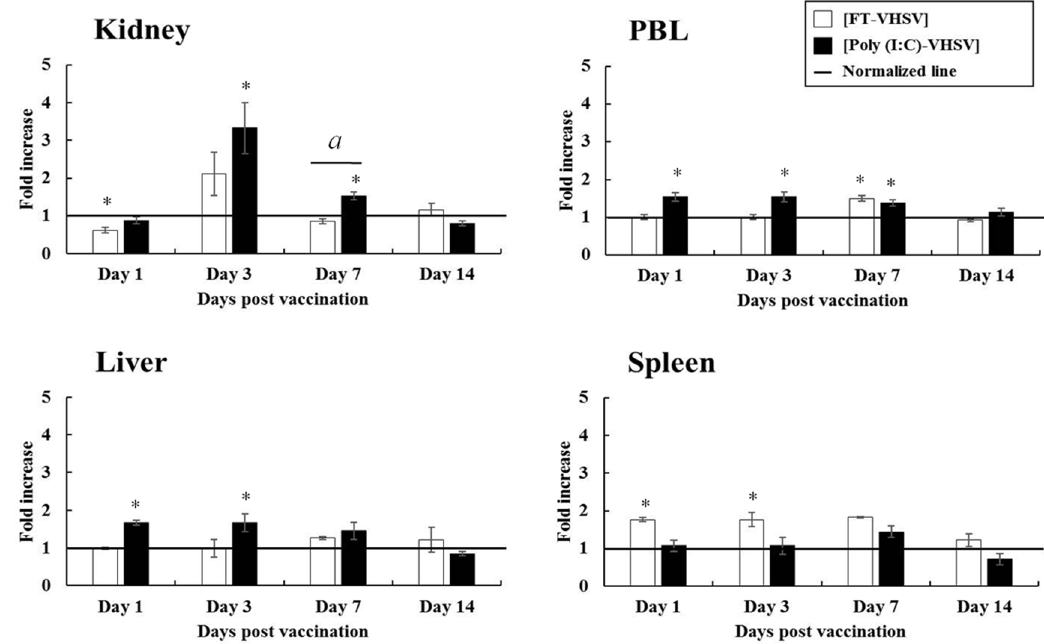
Figure 7. Fold increase in CD4-1 + T cell populations in olive flounder after poly (I:C) potentiated and formalin-treated VHSV vaccination determined by flow cytometry. Leukocytes were isolated at 1, 3, 7, and 14 dpv from the kidney, liver, spleen, and PBL for three fish from both the Poly (I:C)-VHSV ( n = 30) and FT-VHSV ( n = 30) groups. The CD4-1 + T cell response was observed and presented as a fold increase compared to the T cell population in the negative control group (adjusted to 1 and shown by a solid line). Error bars indicate the standard deviation of the mean. Asterisks (*) represent a significant difference between each experimental group and the negative control group by one-way ANOVA ( p < 0.05). Symbol ( a ) indicates a statistical difference between the FT-VHSV and Poly (I:C)-VHSV groups by one-way ANOVA at a particular time point ( p < 0.05).